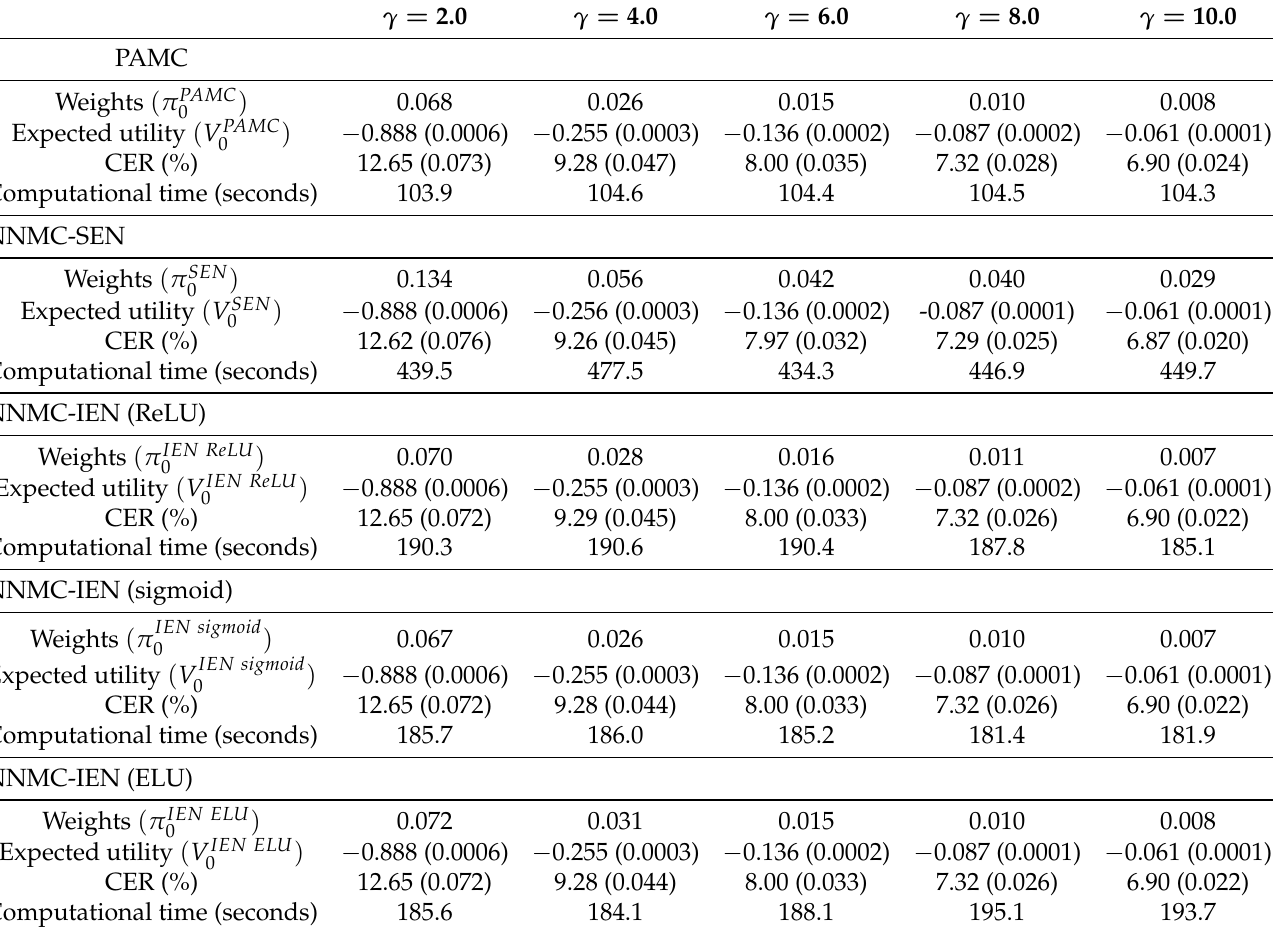
Table 7. Results for the OU 4/2 model. We report the estimation of optimal weights, expected utility and CER obtained via approximations for different levels of risk aversion γ . The standard deviation of estimated expected utility and CER from 100 runs is provided in parentheses. γ = 2.0 γ = 4.0 γ = 6.0 γ = 8.0 γ =